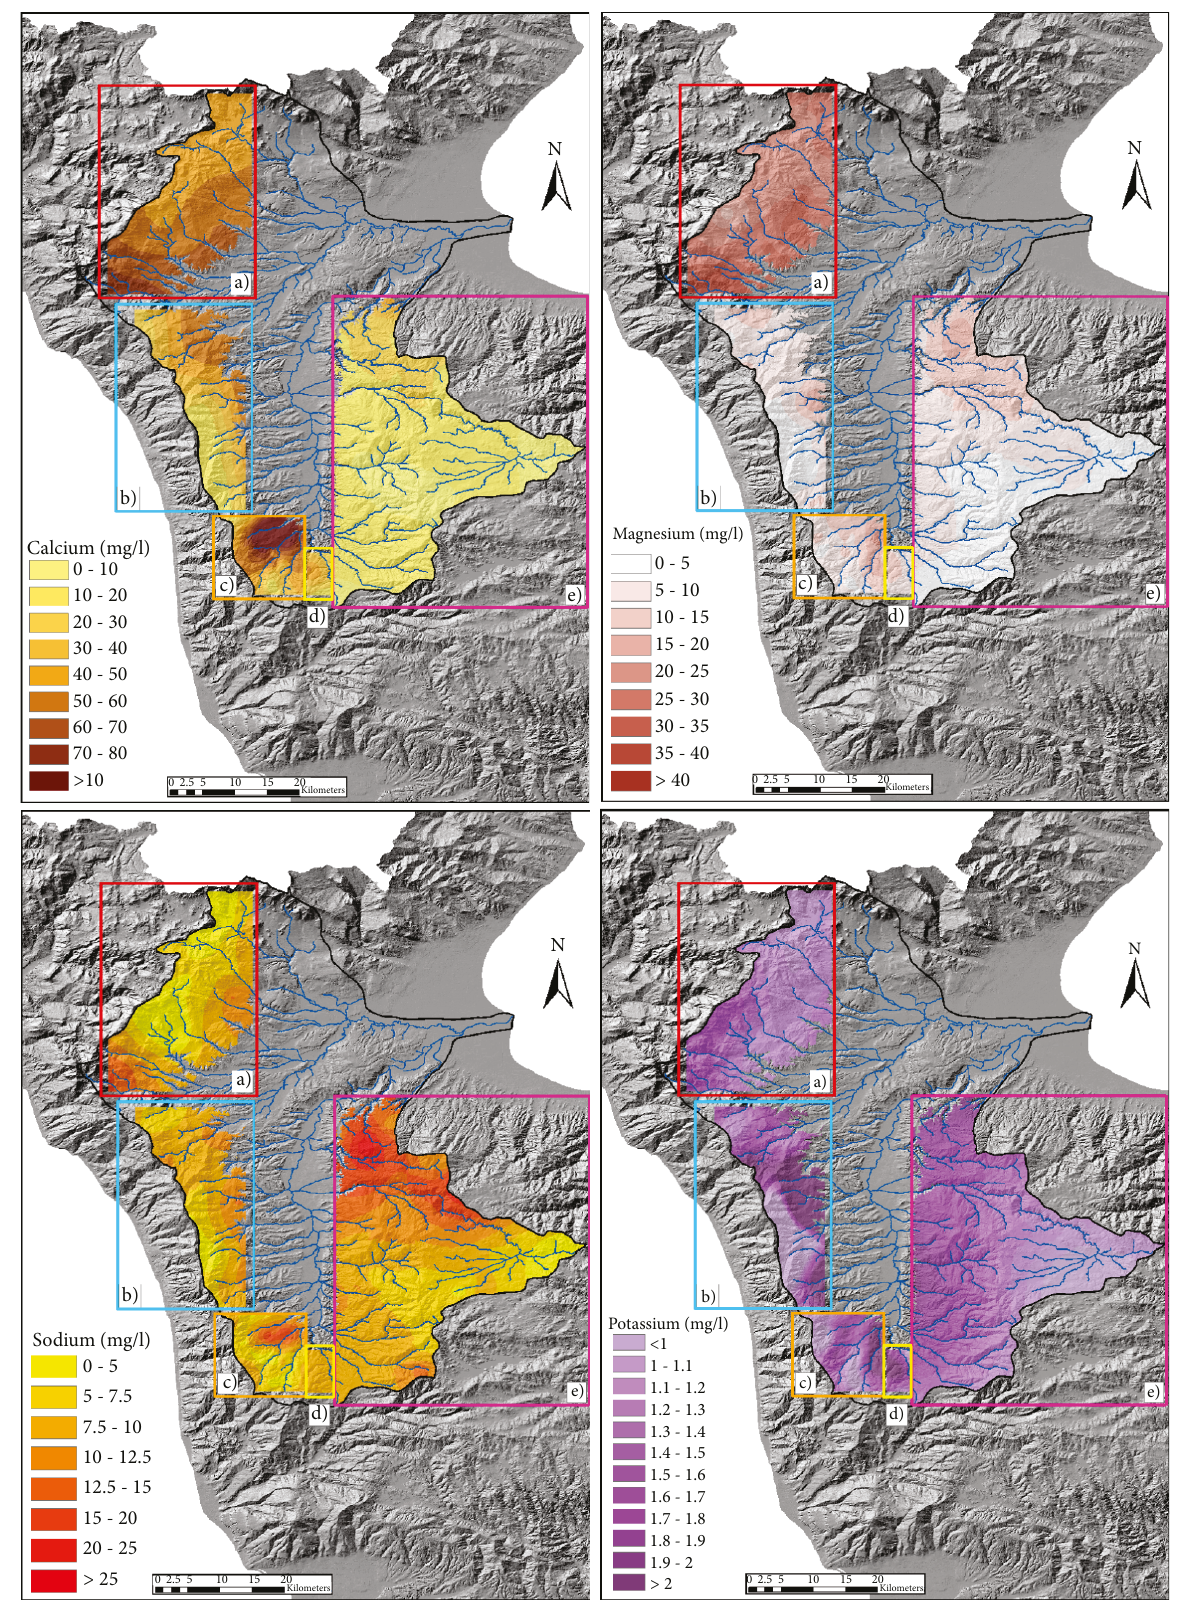
Figure 6: Spatial distribution of concentration of calcium, magnesium, sodium and potassium in waters from the 5 subareas of the Crati river